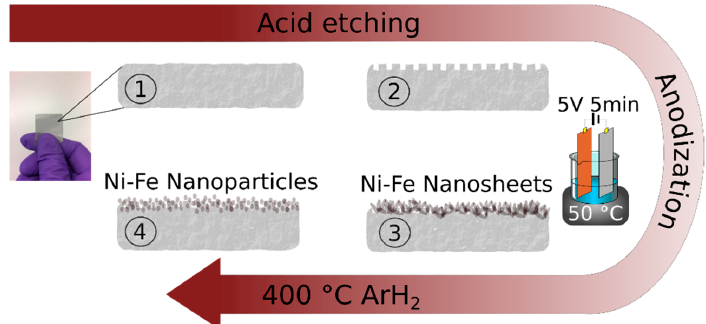
Figure 1. A schematic showing the activation procedure. Firstly, in 1 (cid:79) a stainless steel mesh (SSM-316L) was cleaned and degreased. In 2 (cid:79) the SSM was sonicated in in an acidic solution to increase the surface area. In 3 (cid:79) the SMM was anodized in a 7.5 M NaOH solution by applying 5 V for 5 min to generate nickel-iron nanosheets (SSM-A). Finally in 4 (cid:79) the sample is further annealed in a reducing atmosphere to form nanoparticles